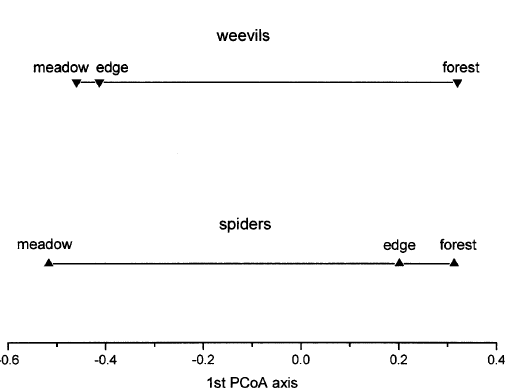
Fig. 1. Ordination of the assemblages by PCoA, based on Bray- Curtis dissimilarity. (Weevils: 77%, spiders: 83% of the total var- iance explained by the 1st